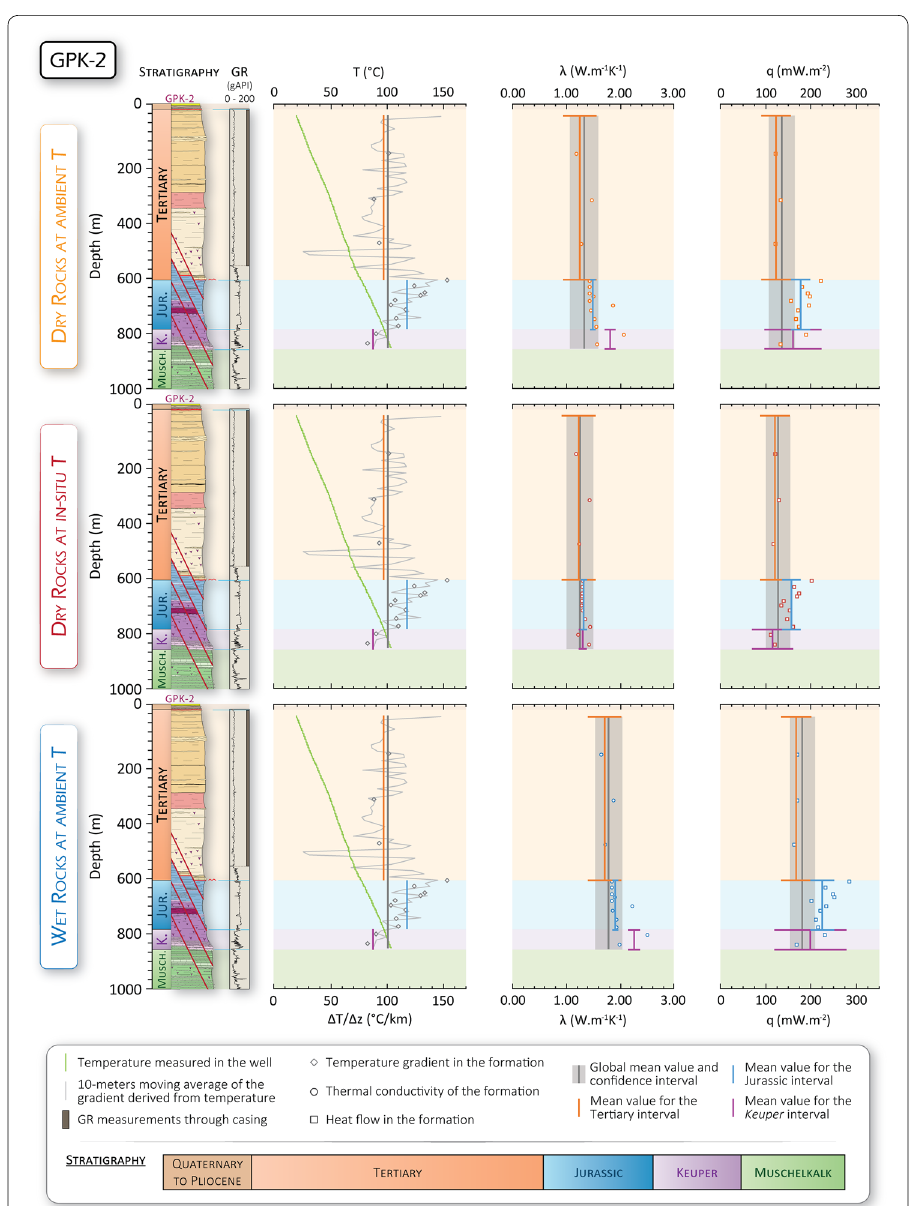
Fig. 11 Stratigraphic log and gamma ray (GR) (after Aichholzer et al. 2016), measured temperature profile T and derived temperature gradient ∆ T /∆ z (same scale as temperature profile), thermal conductivities λ for dry, hot and wet formations and associated calculated heat flow densities q for the Soultz-sous-Forêts GPK-2 well. Vertical lines indicate mean values for ∆ T /∆ z (left), λ (middle) and q (right) for a given interval (global (from surface to top of the Muschelkalk), Tertiary, Jurassic and Keuper). Dots indicate average value for a